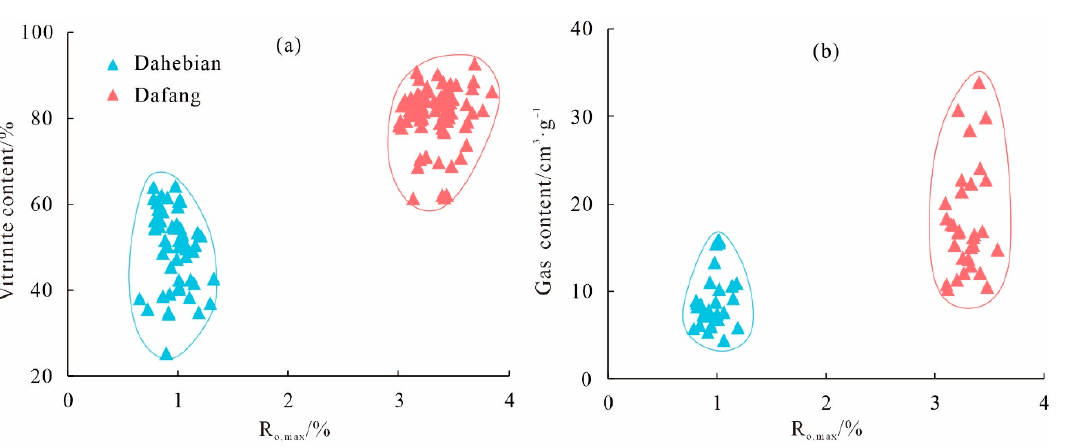
Figure 1. Relationship between vitrinite reflectance with vitrinite content ( a ) and gas content ( b ) of the primary mineable coals.